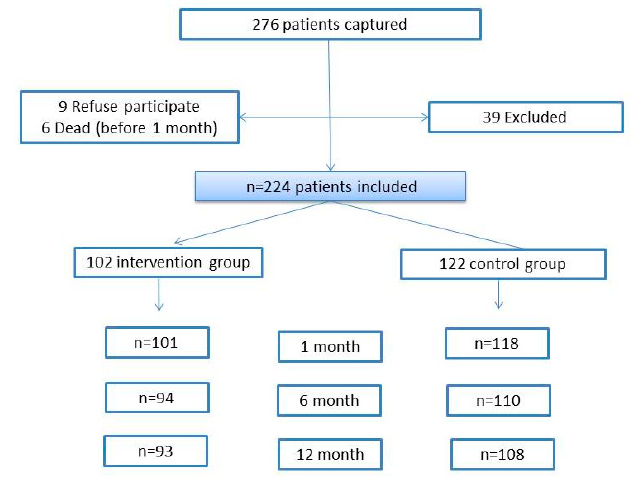
Figure 1. Flowchart of cases.